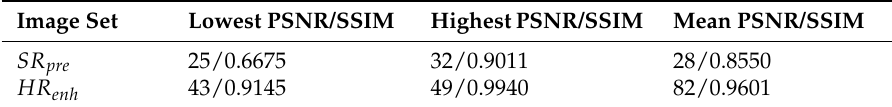
Table 2. PSNR and SSIM index claculated on image